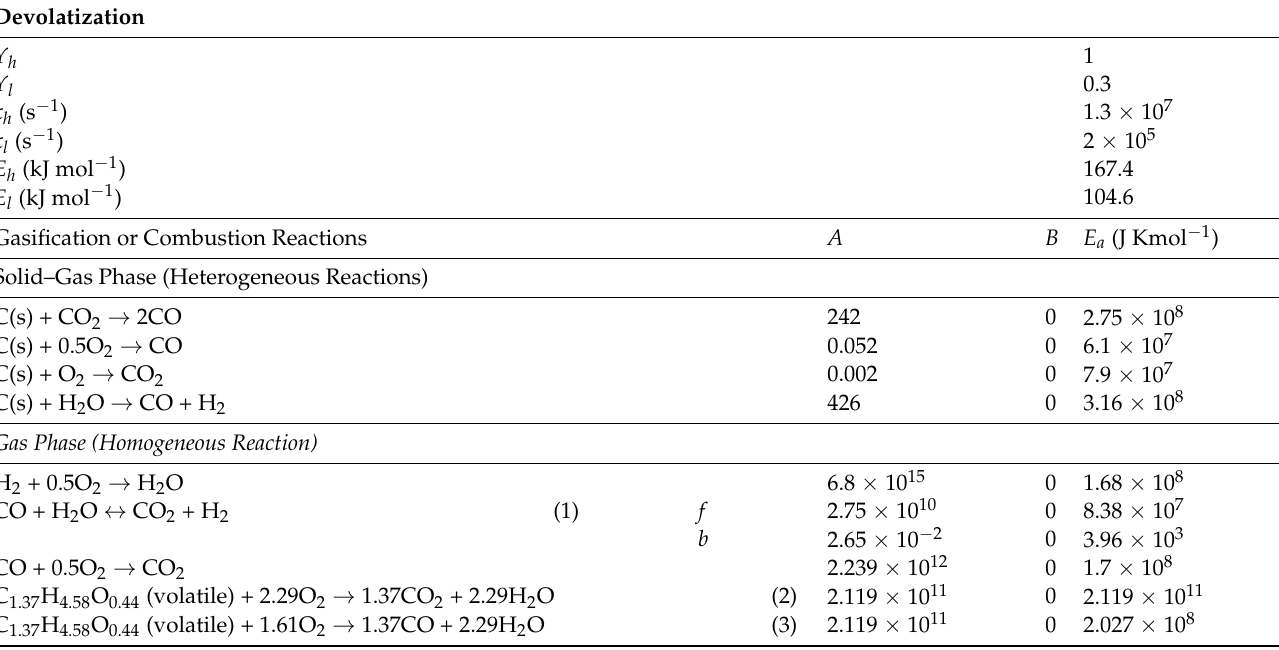
Table 2. The kinetic factors for combustion/gasification and devolatilization reactions.